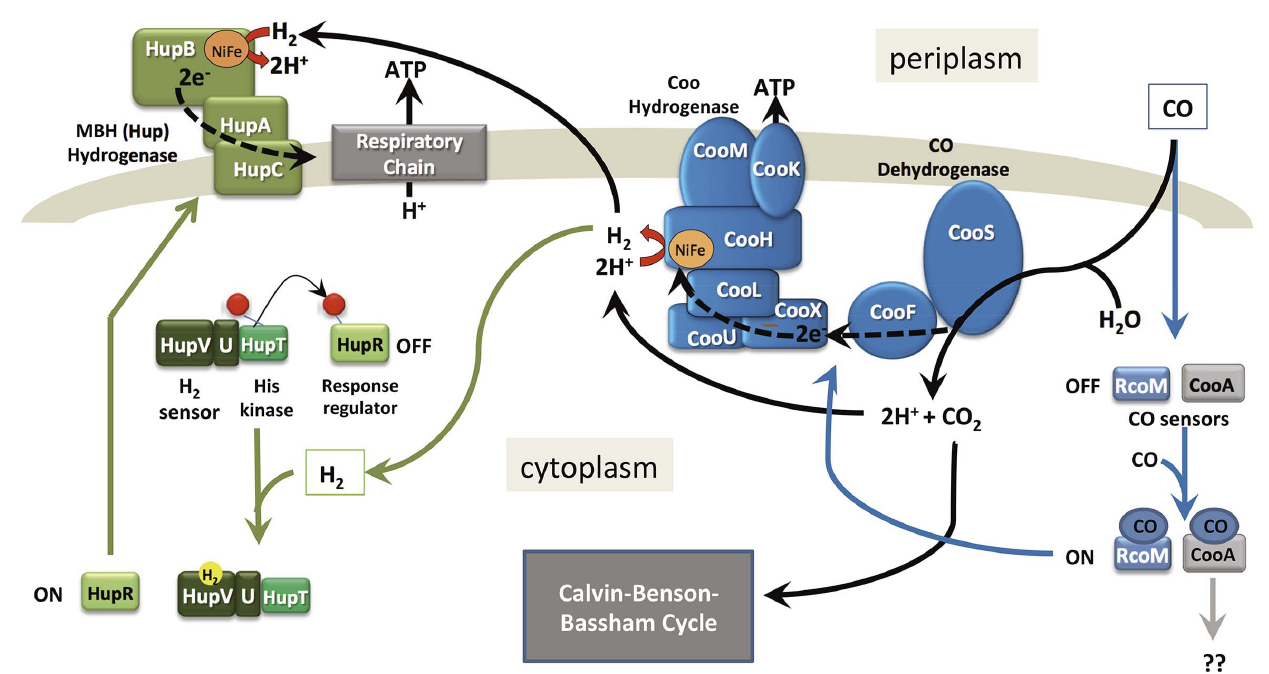
Figure 4. An overview of the CO and H 2 signal transduction pathways and metabolism in Rubrivivax gelatinosus